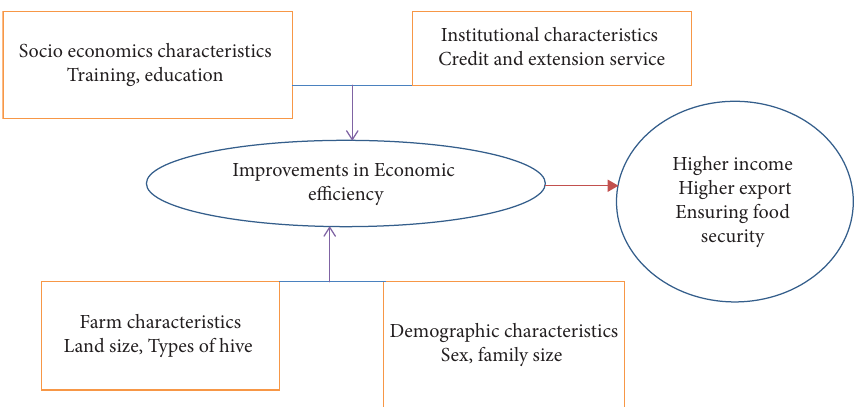
Figure 1: Conceptual framework of the study source: own